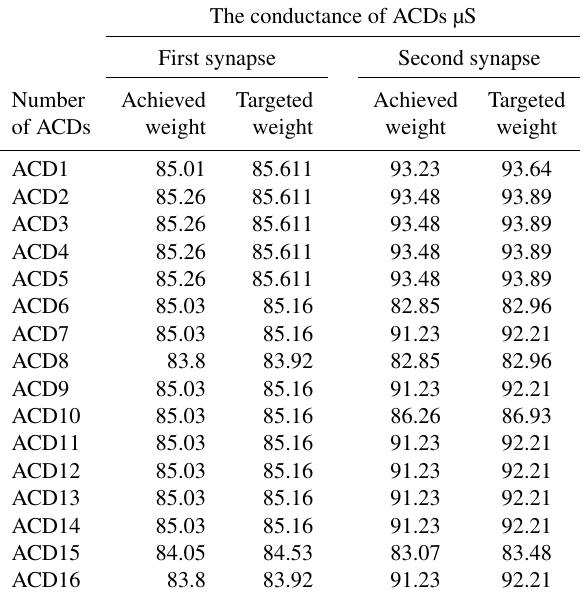
Table 3. The performance of ASRC under worst-case process corners, where T min is − 40 ◦ C, T max is + 85 ◦ C, VDD(typ) is 3.3V, VDD(min) is − 10% VDD(typ), and VDD(max) is + 10% VDD(typ). WS is the worst-case speed, WP is the worst-case power, WZ is the worst-case zero, and WO is the worst-case one.